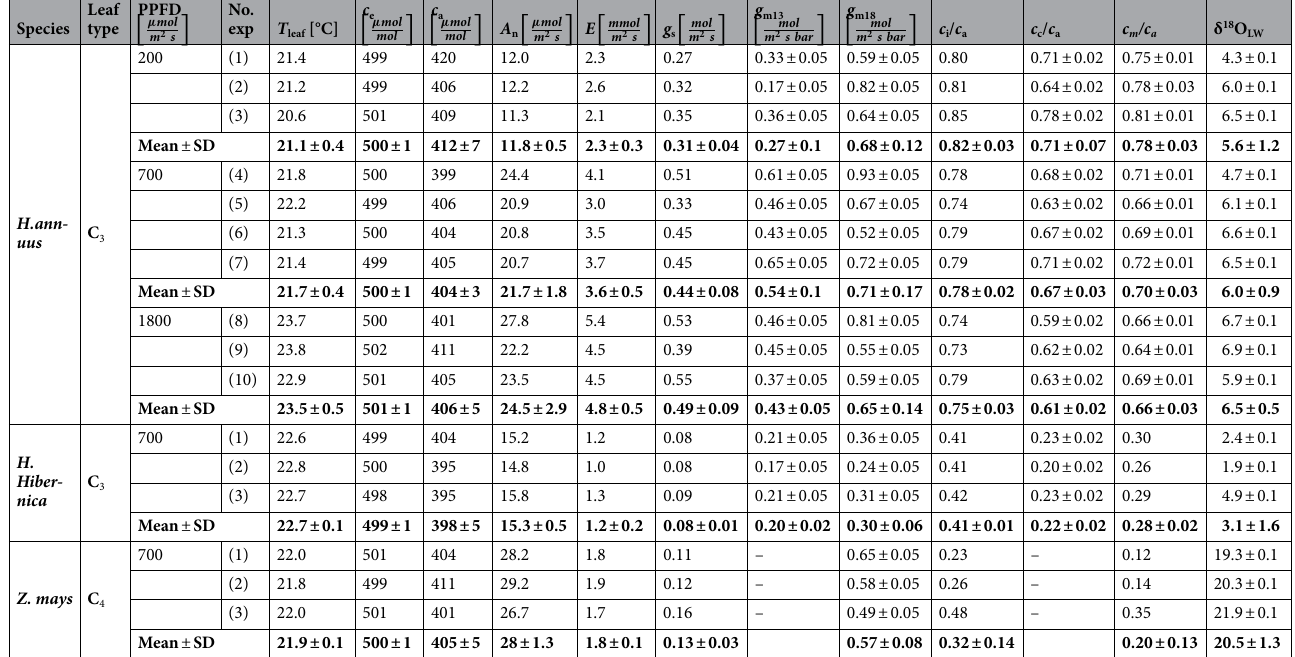
Table 1. Gas exchange variables and isotopic composition of the bulk leaf water. T leaf : leaf temperature; c e : CO 2 concentration of the air entering the leaf cuvette; c a : CO 2 concentration of the air inside the cuvette and leaving the cuvette; A n : net assimilation rate; E : transpiration rate; g s : stomatal conductance for CO 2 ; c i : CO 2 concentration in the intercellular airspace; c c : CO 2 concentration in the chloroplasts (site of CO 2 uptake); c m : CO 2 concentration in the mesophyll cell; g m13 : mesophyll conductance from the intercellular airspace to the chloroplasts; g m18 : mesophyll conductance from the intercellular airspace to the CO 2 -H 2 O exchange site; δ 18 O LW : δ 18 O value of the bulk leaf water vs VSMOW (‰). The values in bold are mean and standard deviation for the replicates at different light